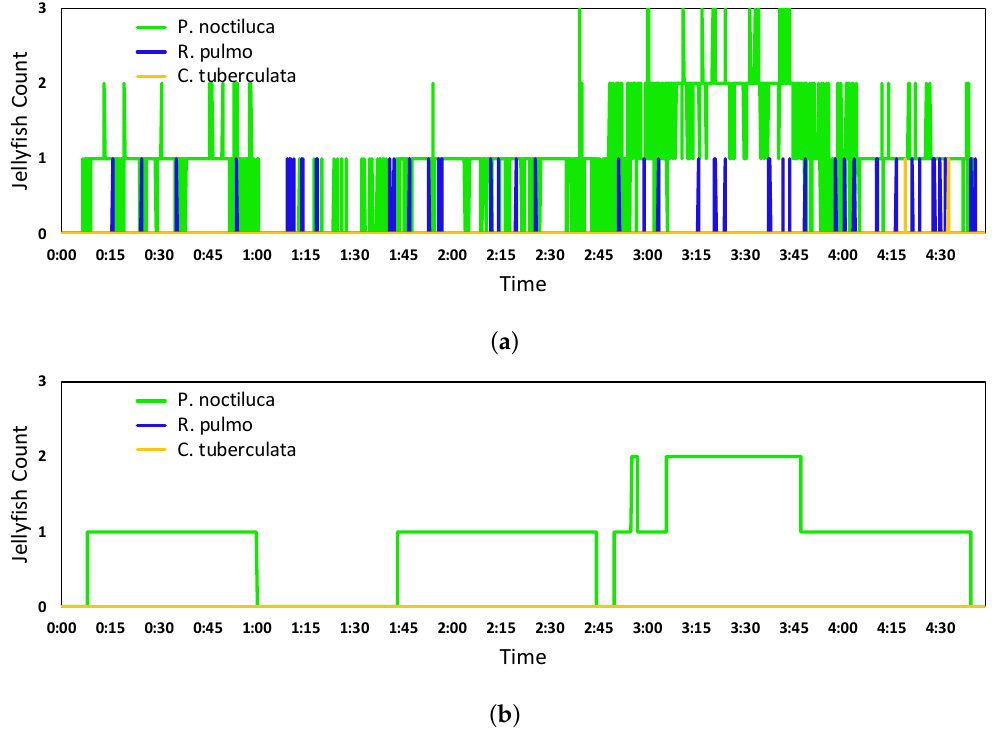
Figure 11. Results of the jellyfish count from the ResNet101 network final predictions ( a ) and quantification algorithm ( b ).